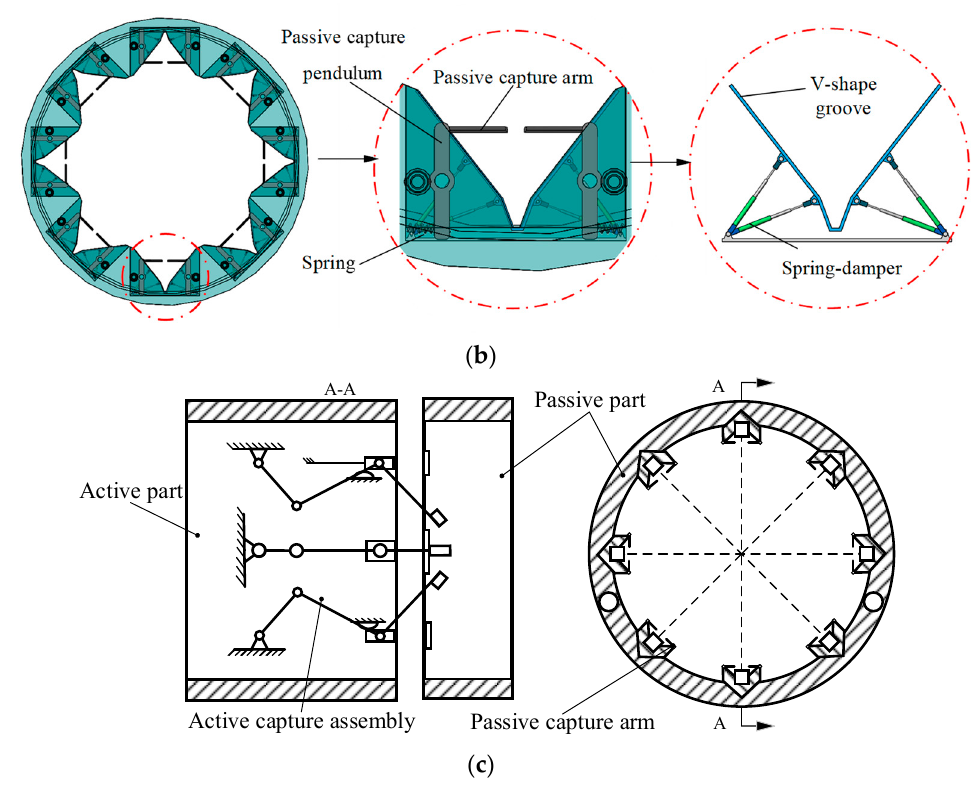
Figure 2. System configuration: ( a ) Active part; ( b ) Passive part; ( c ) Sketch of the docking process.